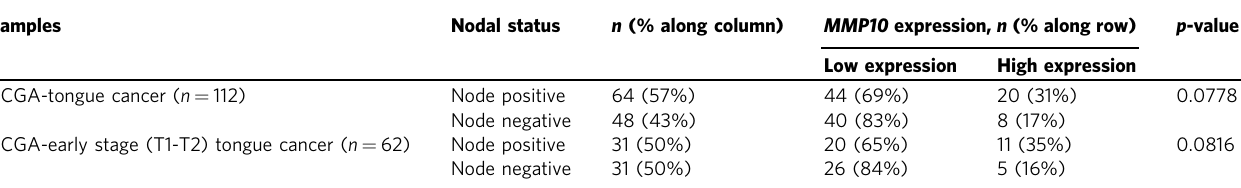
Table 1 Association of lymph node metastasis with MMP10 expression in TCGA-tongue cancer data. Samples Nodal